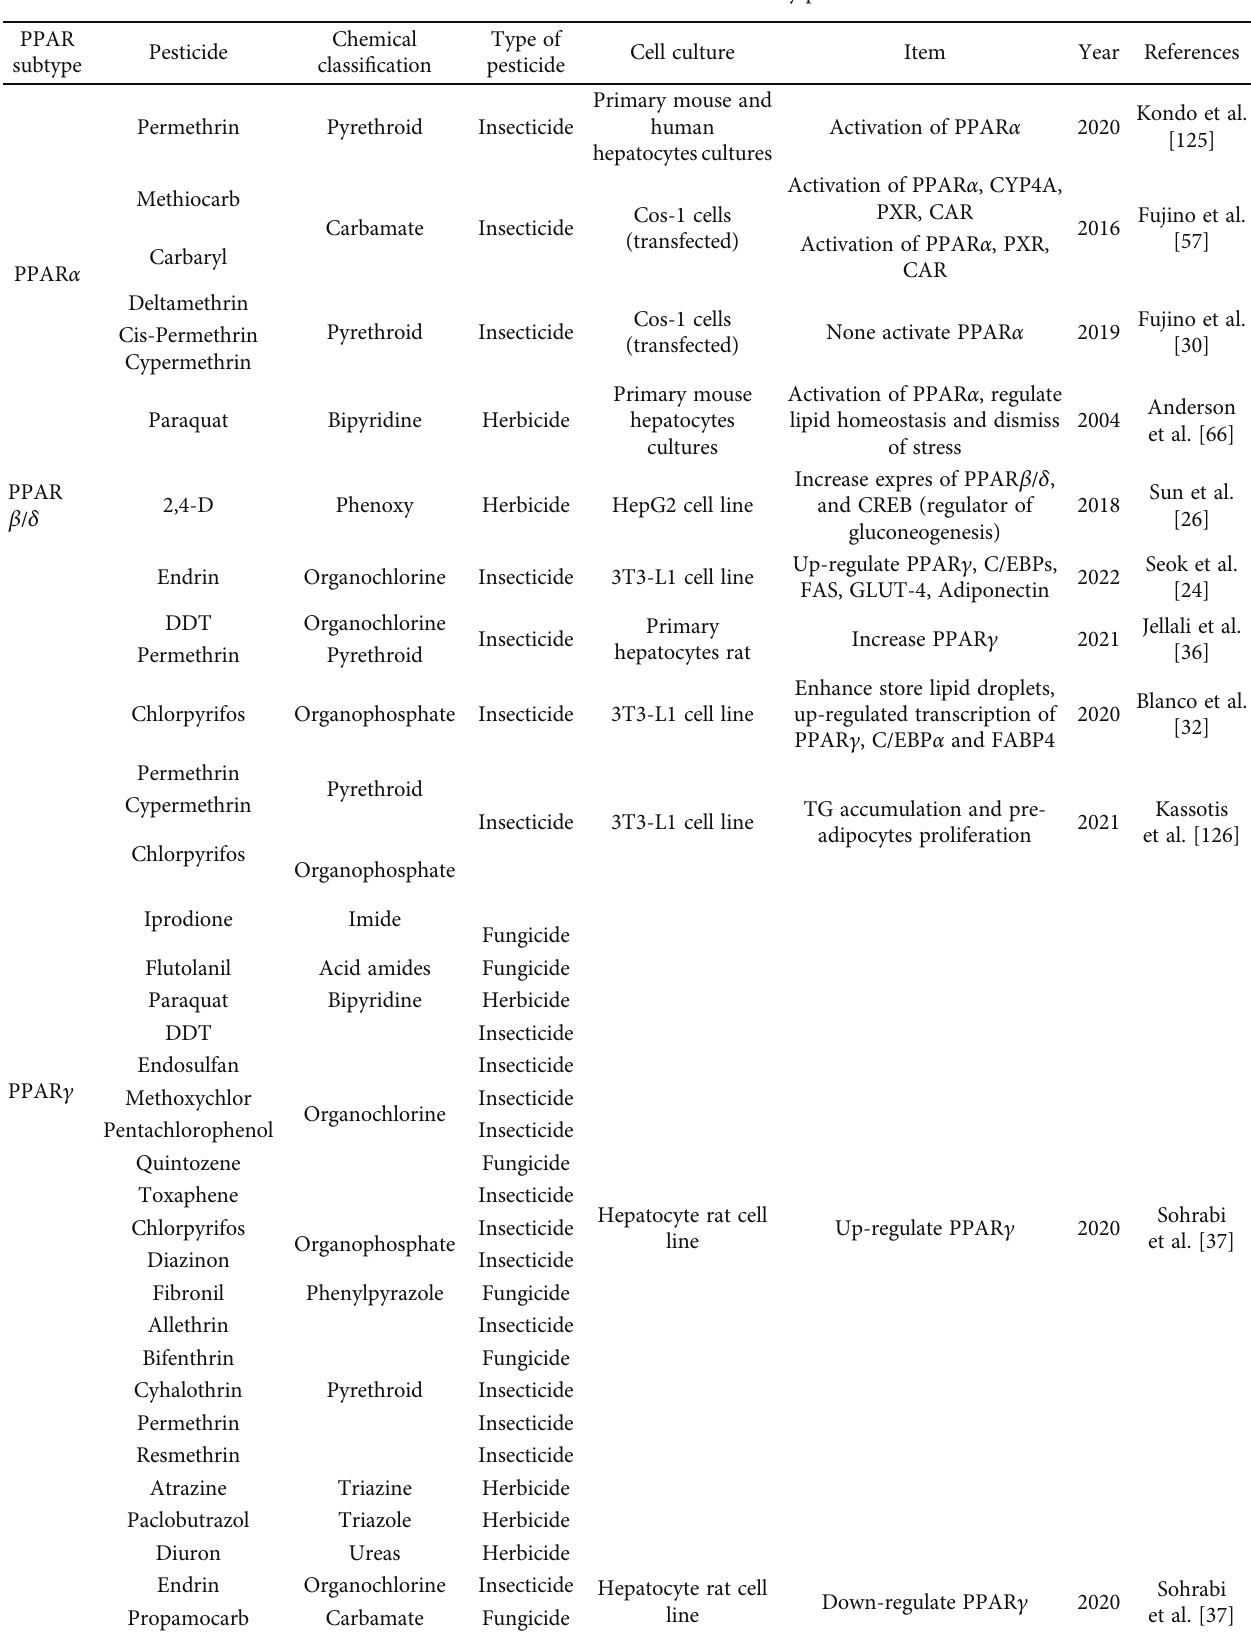
Table 2: In vitro studies of activation PPARs by